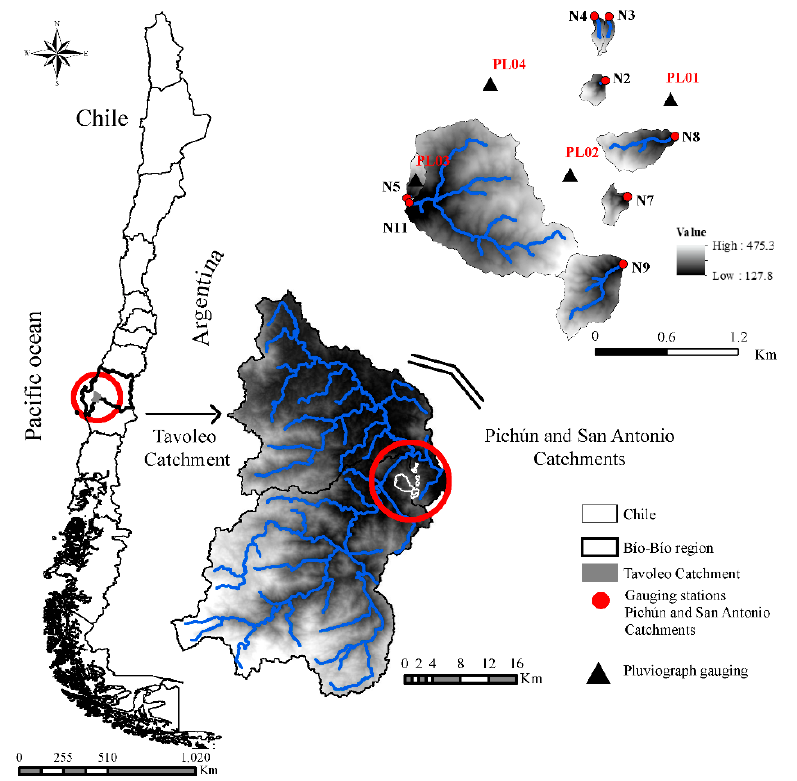
Figure 1. Experimental catchments located in the Chilean Coastal Range (37°28 ′ S, 72°42 ′ W), Biobío region.